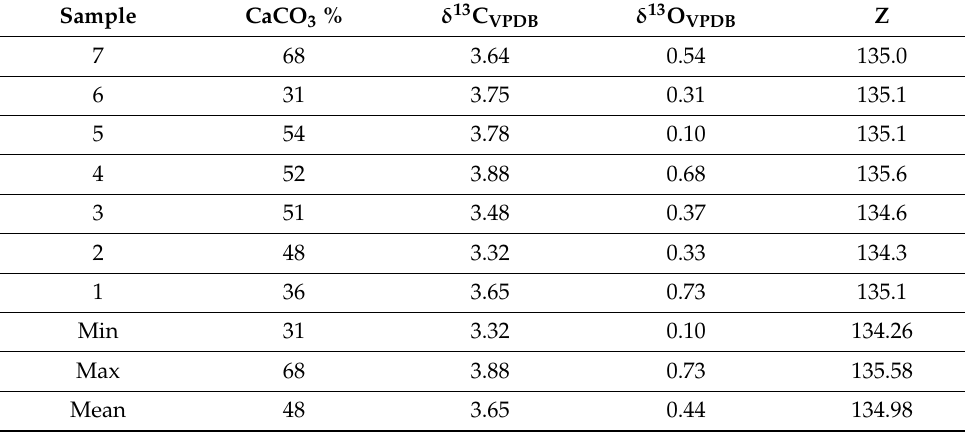
Figure 4. Photomicrographs showing the framework composition and the cement in the beachrock of Al-Mejarma: ( a , b ) Varieties of siliciclastic grains dominated by mono- and polycrystalline quartz (Qz) and feldspar (fels) mixed with skeletal remains dominated by benthic foraminifera (bf), coralline red algae (alg), bivalves (bv), and intergranular pores (p); the grains are cemented by HMC mainly in the form of isopachous rims and rarely as microcrystalline meniscus bridge between grains (yellow arrow); ( c , d ) HMC cement grows as isopachous fringes with elongated bladed crystals regularly surrounding skeletal remains and filling the intragranular pore (IntP) in the foraminifera test. (The scale bar in ( a , b ) = 200 µ m and in ( c , d ) = 40 µ m). Table 1. The CaCO 3 content of the bulk beachrock samples and stable isotope, and Z values of carbonate cement in the Al-Mejarma beachrock. The isotopic values are normalized to Vienna Pee Dee Belemnite